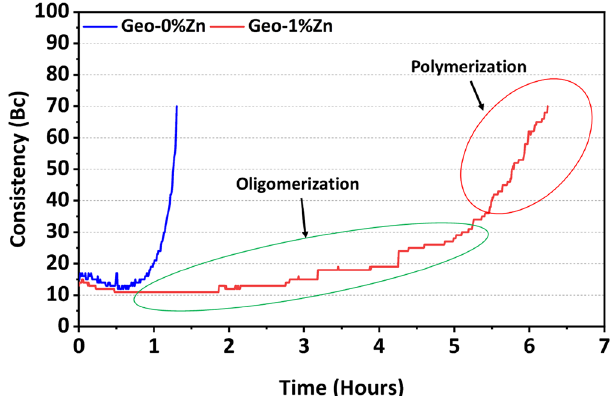
Figure 1. Effect of Zn 2+ species on pumping time of granite-based geopolymer—oligomerization and polycondensation phases highlighted for